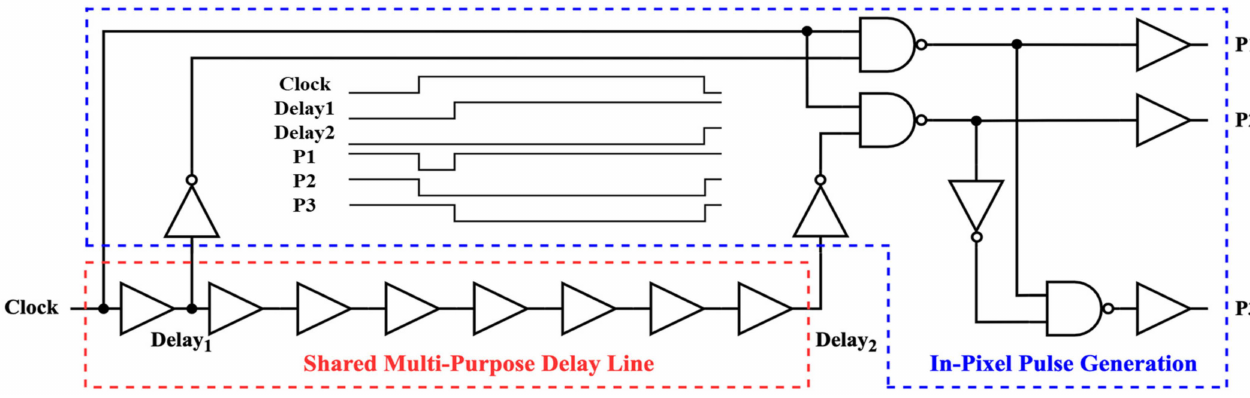
Figure 5. Simplified schematic of the time-gated pulse generation circuitry with an insertion of the timing